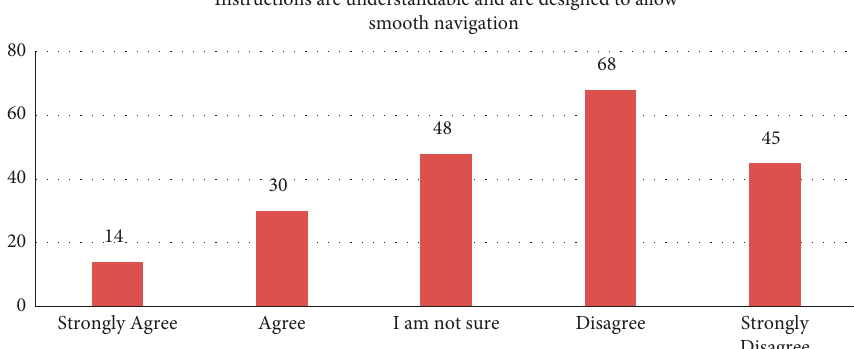
Figure 5: Participants’ responses regarding the assumptions of clear instructions and smooth navigation.